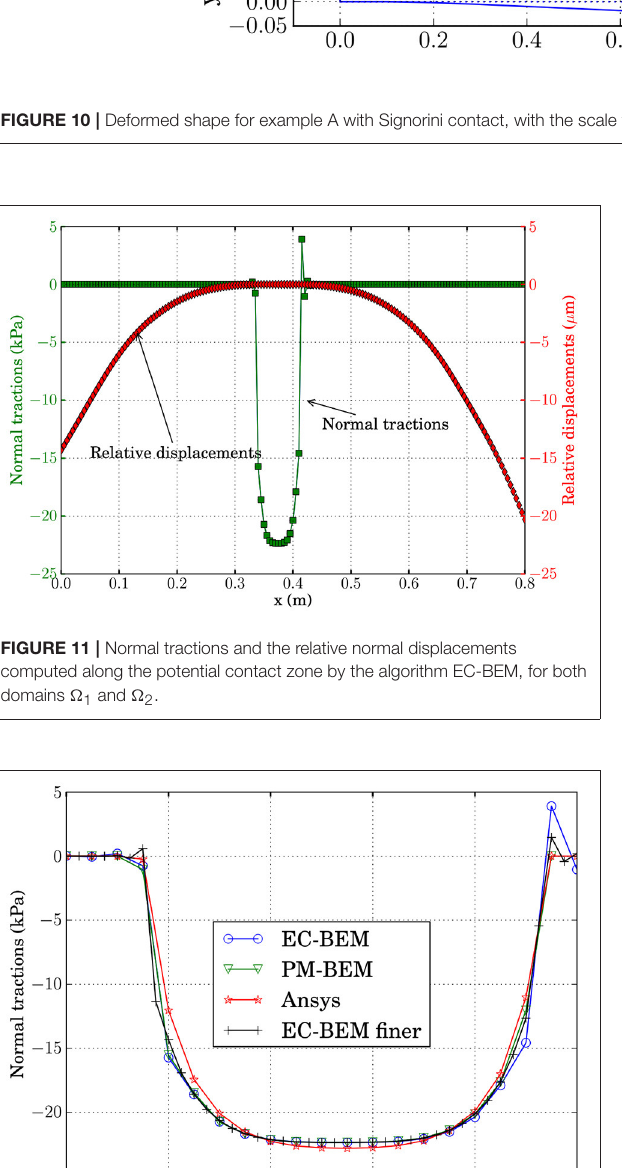
the contact zone depends on the value of the prescribed loading.